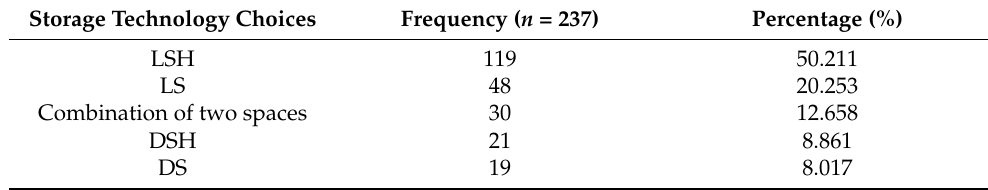
Table 9. Storage technology combinations included in the multinomial probit model. Storage Technology